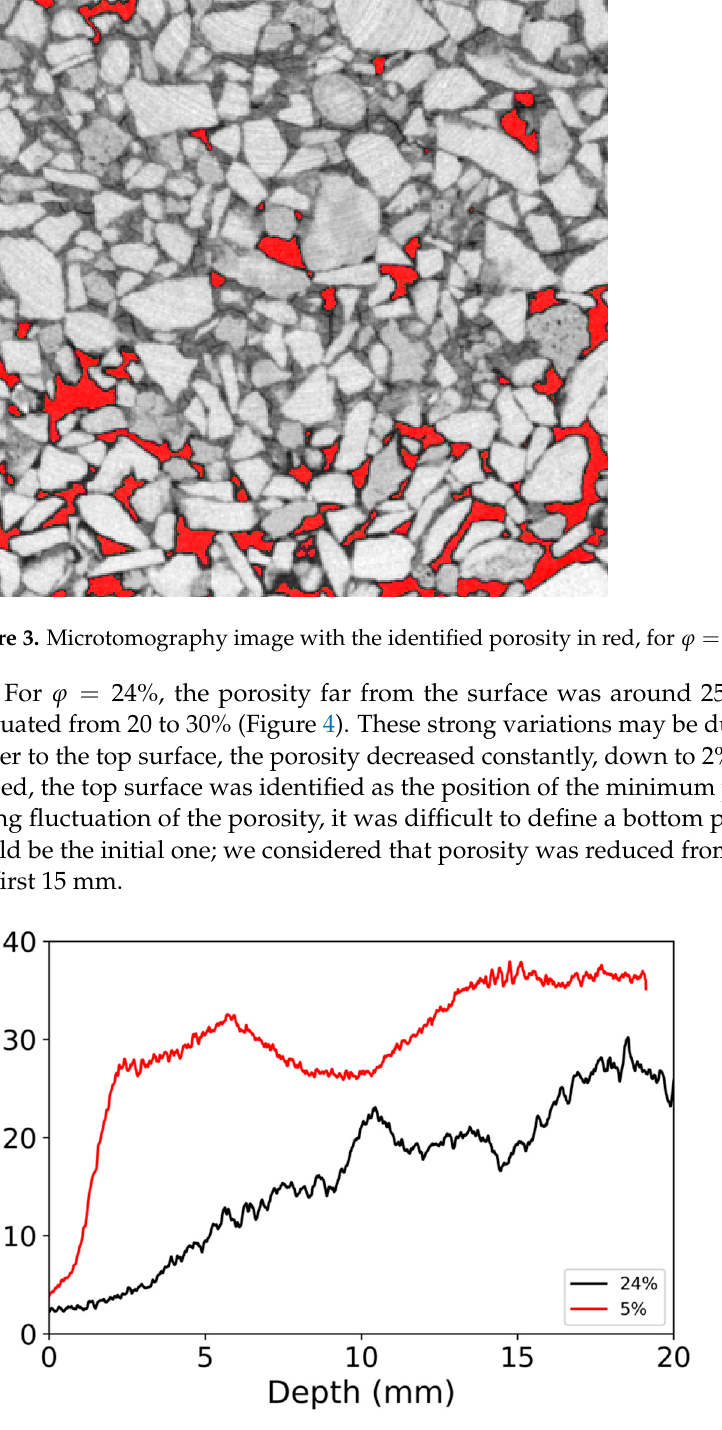
Figure 4. Porosity profile as a function of depth from the top surface. Black: initial particle volume fraction 𝜑 = 24% ; red: initial particle volume fraction 𝜑 = 5% .